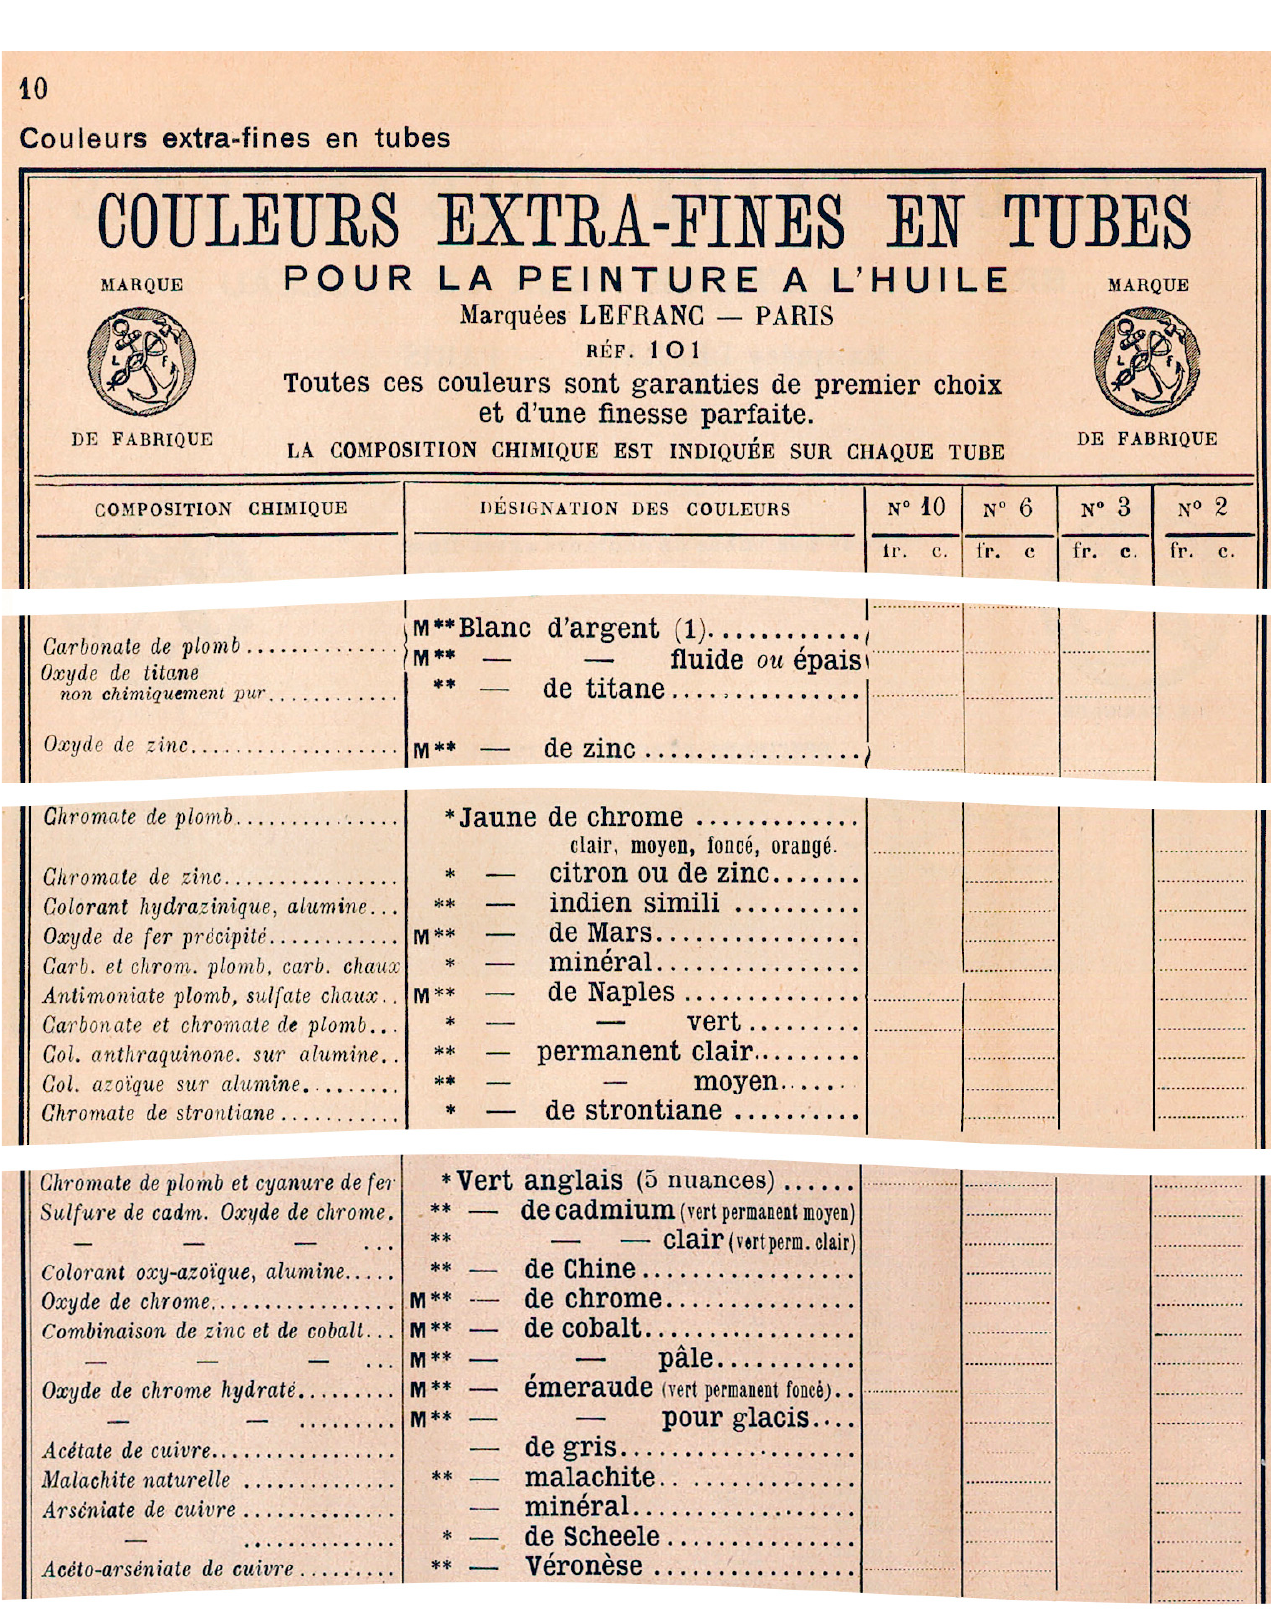
Figure A3. Selected oil colours and their pigment compositions, listed in the catalogue of Lefranc from 1934.